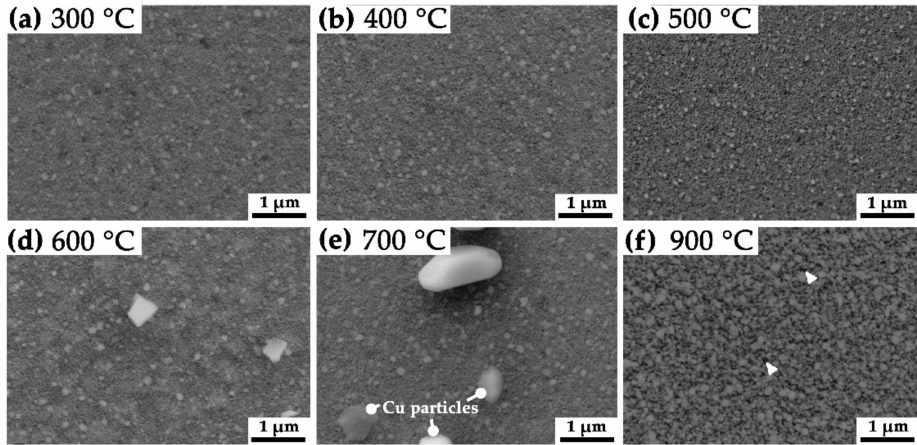
Figure 1. SE SEM images of the HPT processed W/Cu specimens after 1 h annealing at temperatures of ( a ) 300, ( b ) 400, ( c ) 500, ( d ) 600, ( e ) 700 and ( f ) 900 ◦ C. Within ( d , e ) faceted Cu particles become visible on the polished surfaces. In ( f ) the formation of pores along the surface is visible and marked by white arrows.